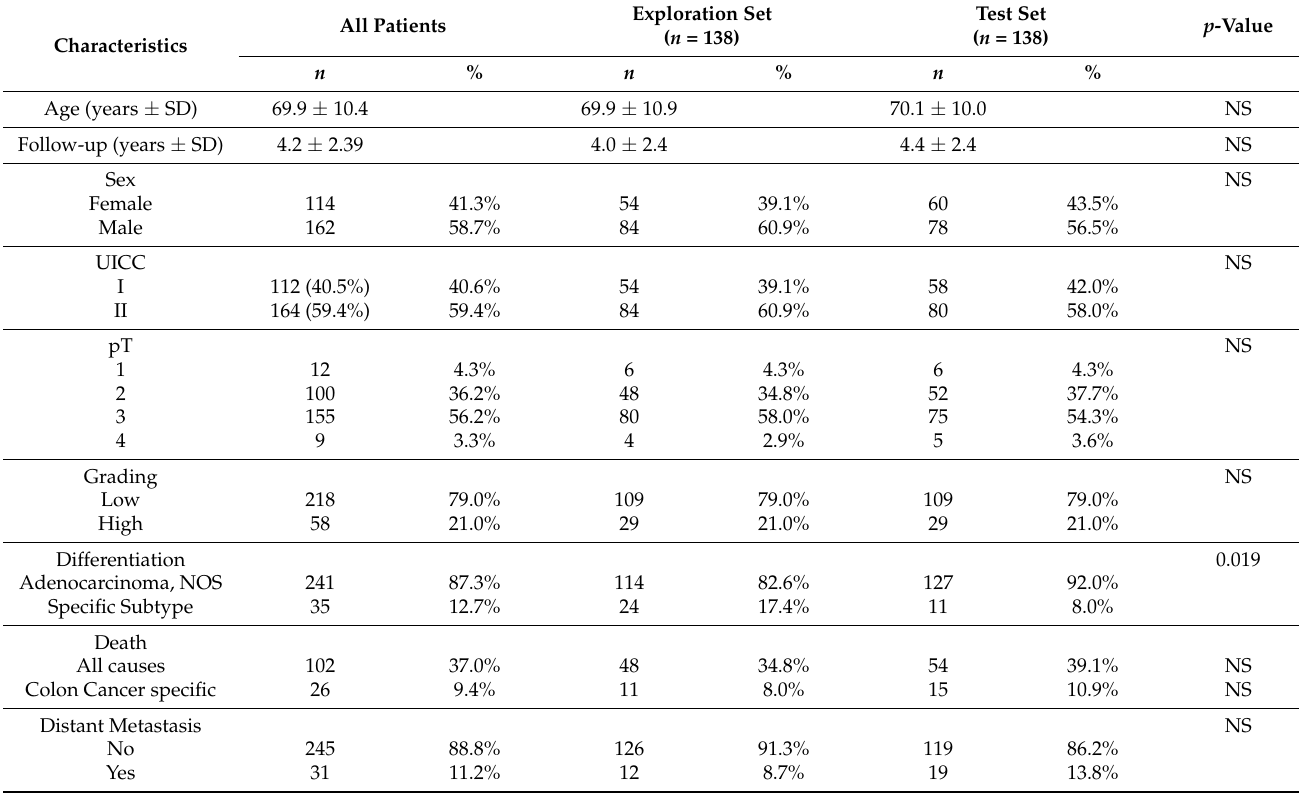
Table 1. Overview of patients’